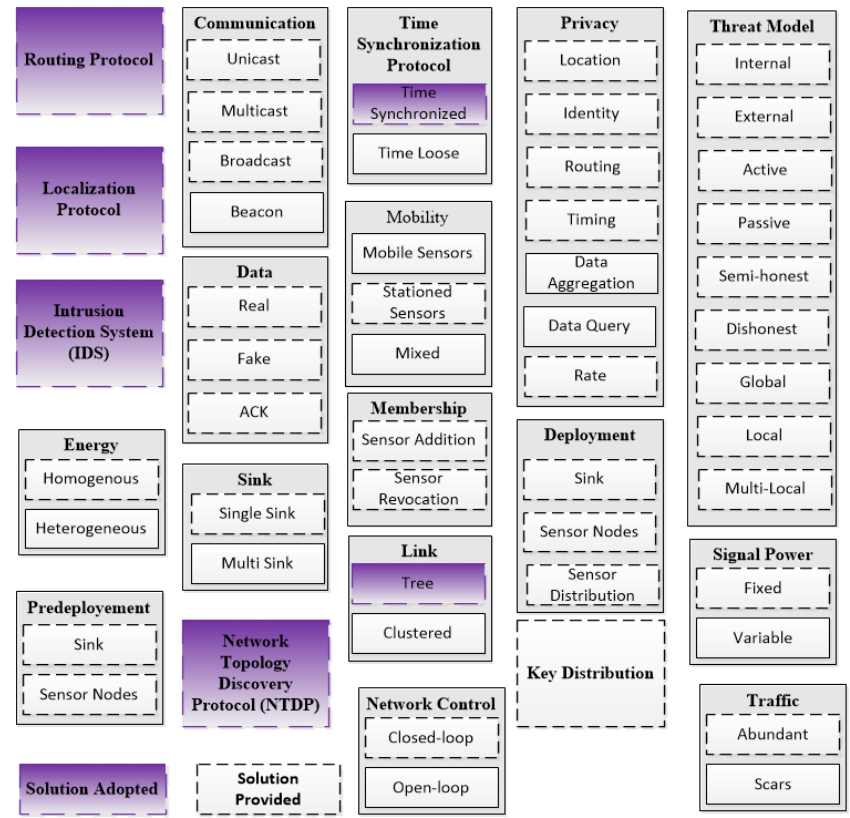
Figure 2. Adopted and provided modules for the framework.